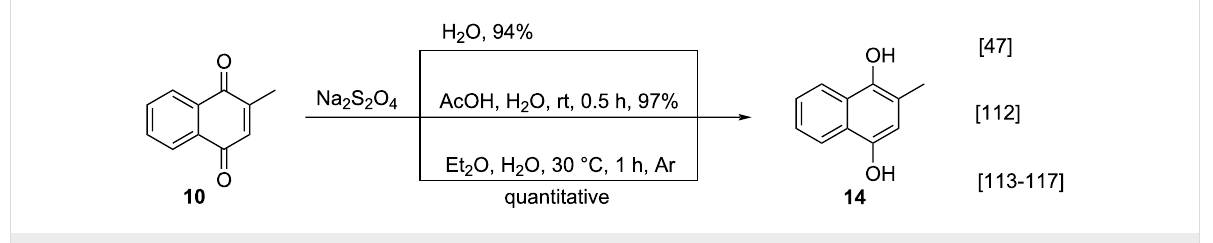
Scheme 19: Menadione reduction reactions using sodium